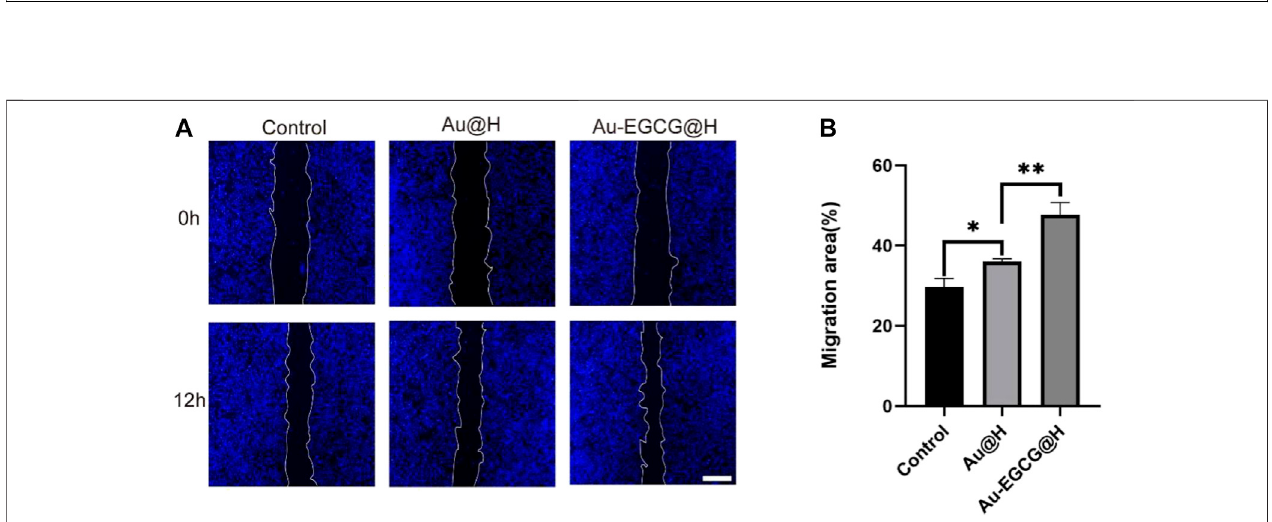
FIGURE3| Thehumanumbilicalveinendothelialcell(HUVEC)migrationtreatedbyAu-EGCG@HandAu@H,respectively. (A) Thescratch-woundassayindifferent treatments, bar (cid:2) 200 μ m. (B) Migration area analysis. * p < 0.05, ** p < 0.01, *** p < 0.001.